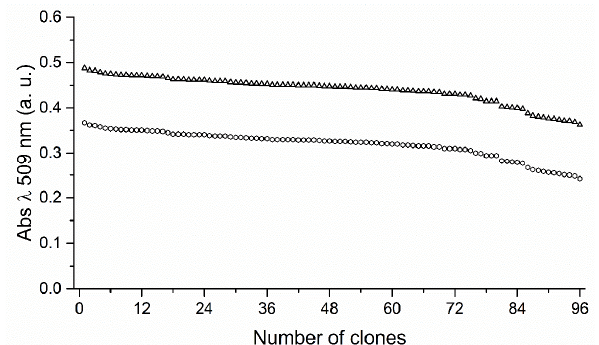
Figure A2. Standard deviation of the 4-AAP assay with P450 BM3 WT. Measured absorption values at λ 509 nm in descending order of P450 BM3 WT catalyzed conversion of benzo-1,4-dioxane in a 96-well plate. The apparent standard deviation (6.8%) is depicted with white triangles. The white hexagons show the true standard deviation (9.4%) after subtraction of the empty vector background.